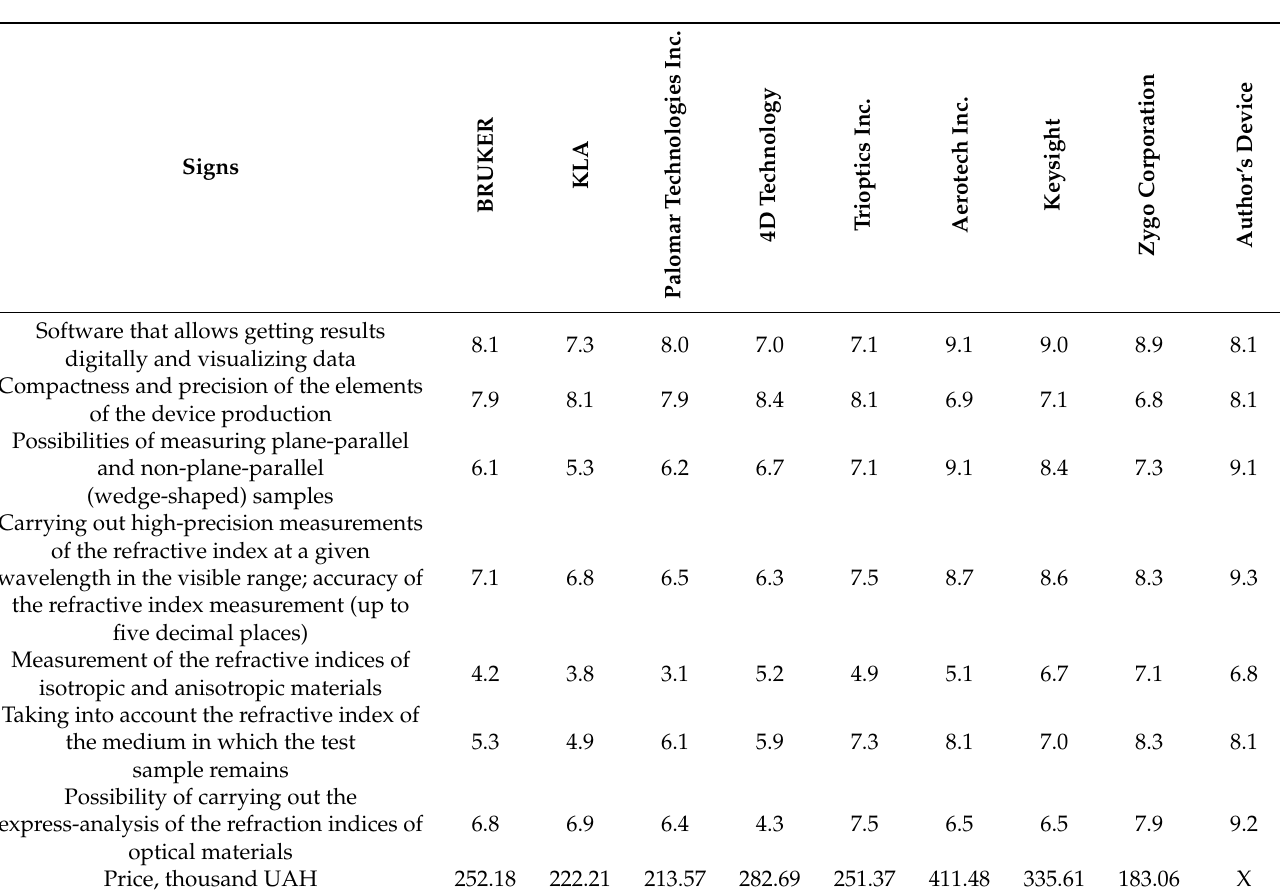
Table 5. Results of the evaluation and market prices for competitive analogues of the device for the interferometric determination of the refractive index of crystalline materials in the optical range (North American region) 1